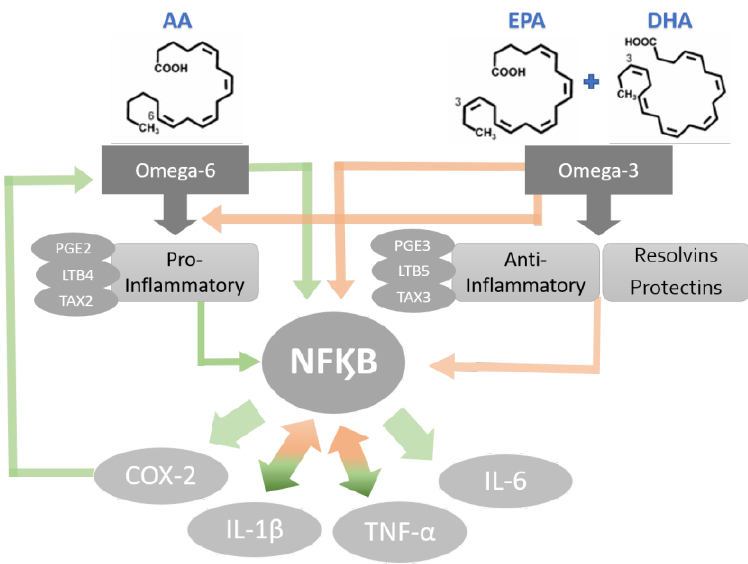
Figure 3. Potential mechanisms of PUFA-activated cytokine production. Green bold arrows indicate activation or up-regulation and red bold arrows represent inhibition or down regulation.